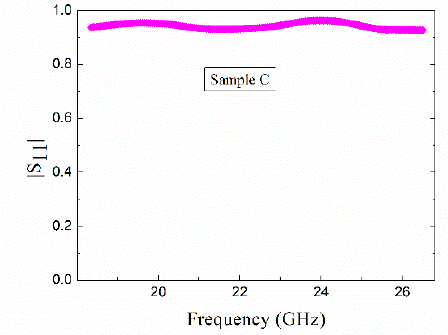
| S | of sample C in the T / R Figure 7. |S 11 | of sample C in the T/R measurement. Figure 7. 11